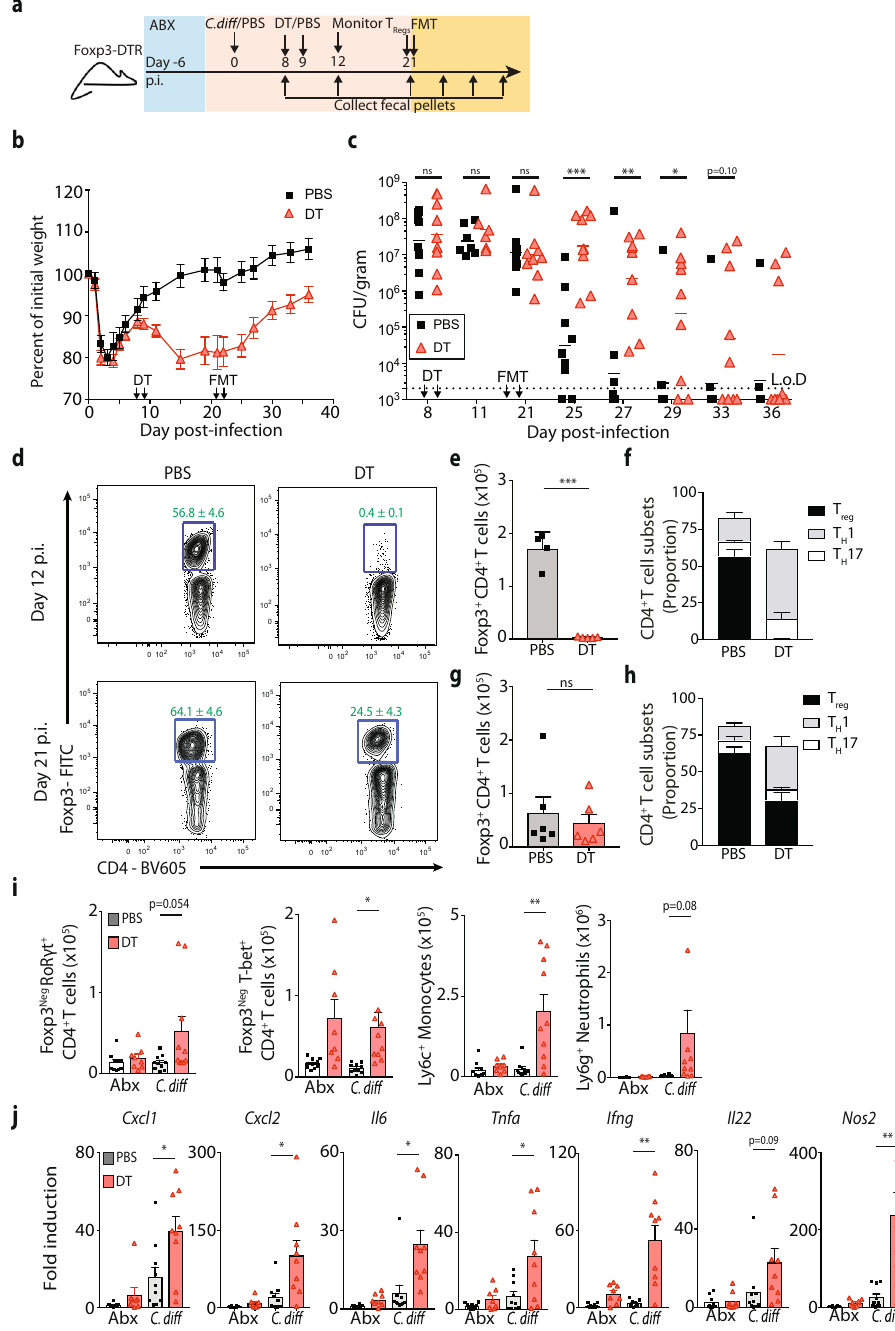
(Fig. 5D, H and Supplementary Fig. 8d, h) and PERMANOVA test (Supplementary Table 3) all demonstrated the microbiota of FMT-responsive mice more closely resembled the FMT inoculum than the microbiota of FMT non-responsive mice. C. dif fi cile infected Rag1 HET or Rag1 − / − mice receiving PBS instead of FMT did not exhibit signi fi cant microbiota composition changes (Supplementary Fig. 9A, B) and remained colonized with C. dif fi cile (Supplementary Fig. 9C). To identify the microbial species that differential engraft in FMT responsive vs. non-responsive mice, the 16S rRNA sequence dataset from C. dif fi cile infected Rag1 HET or Rag1 − / − mice before and after FMT was analyzed for amplicon sequence variants (ASVs) that met the following criteria: (1) present in the